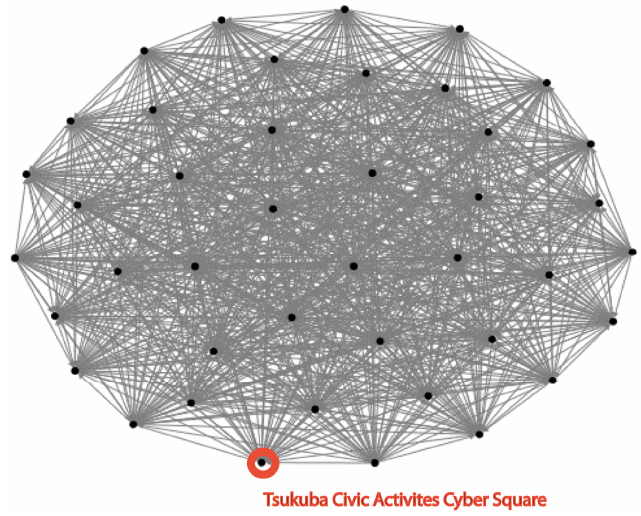
Figure 5. Node XL analysis result map of volunteering (28 January 2016).